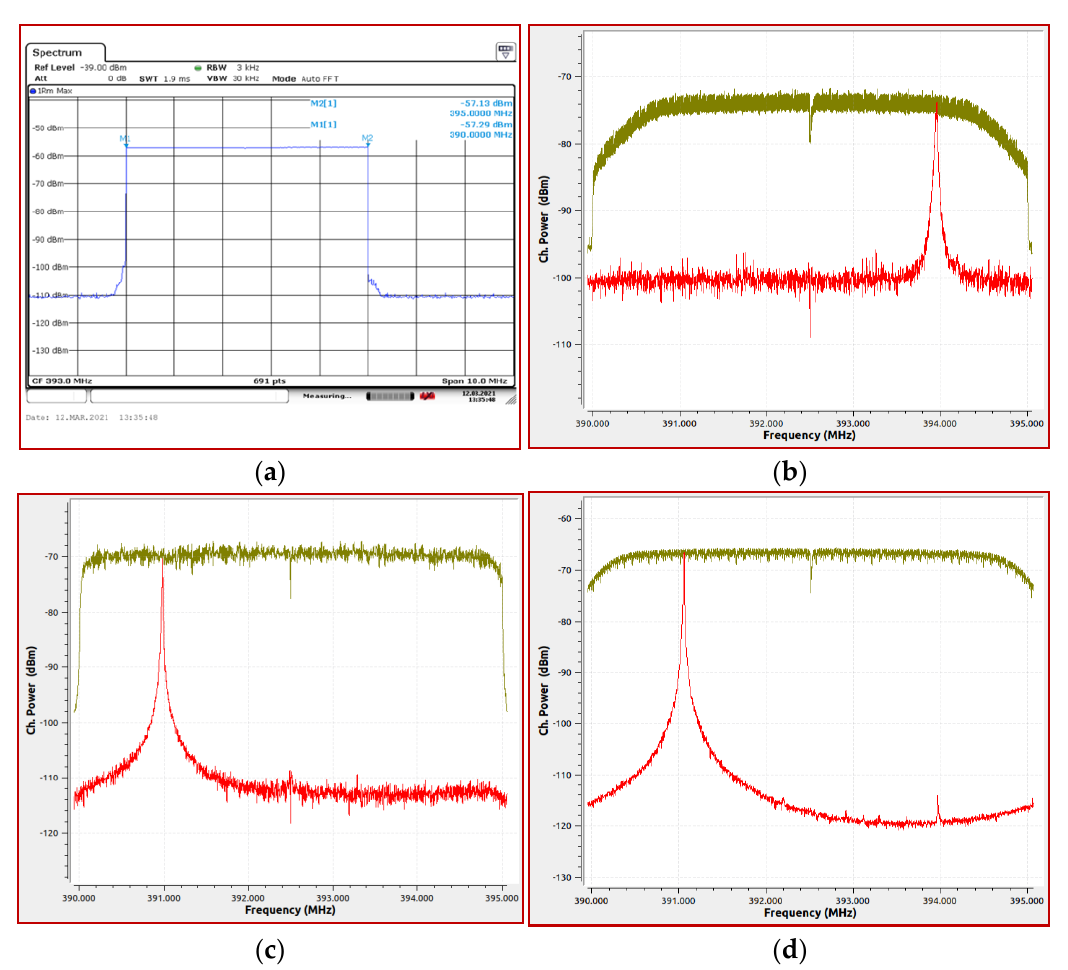
Figure 12. The frequency response, comparatively, in the frequency range (390 – 395) MHz: ( a ) R&S FSV13; ( b ) HackRF One; ( c ) ADALM Pluto; ( d ) NI USRP 2930.